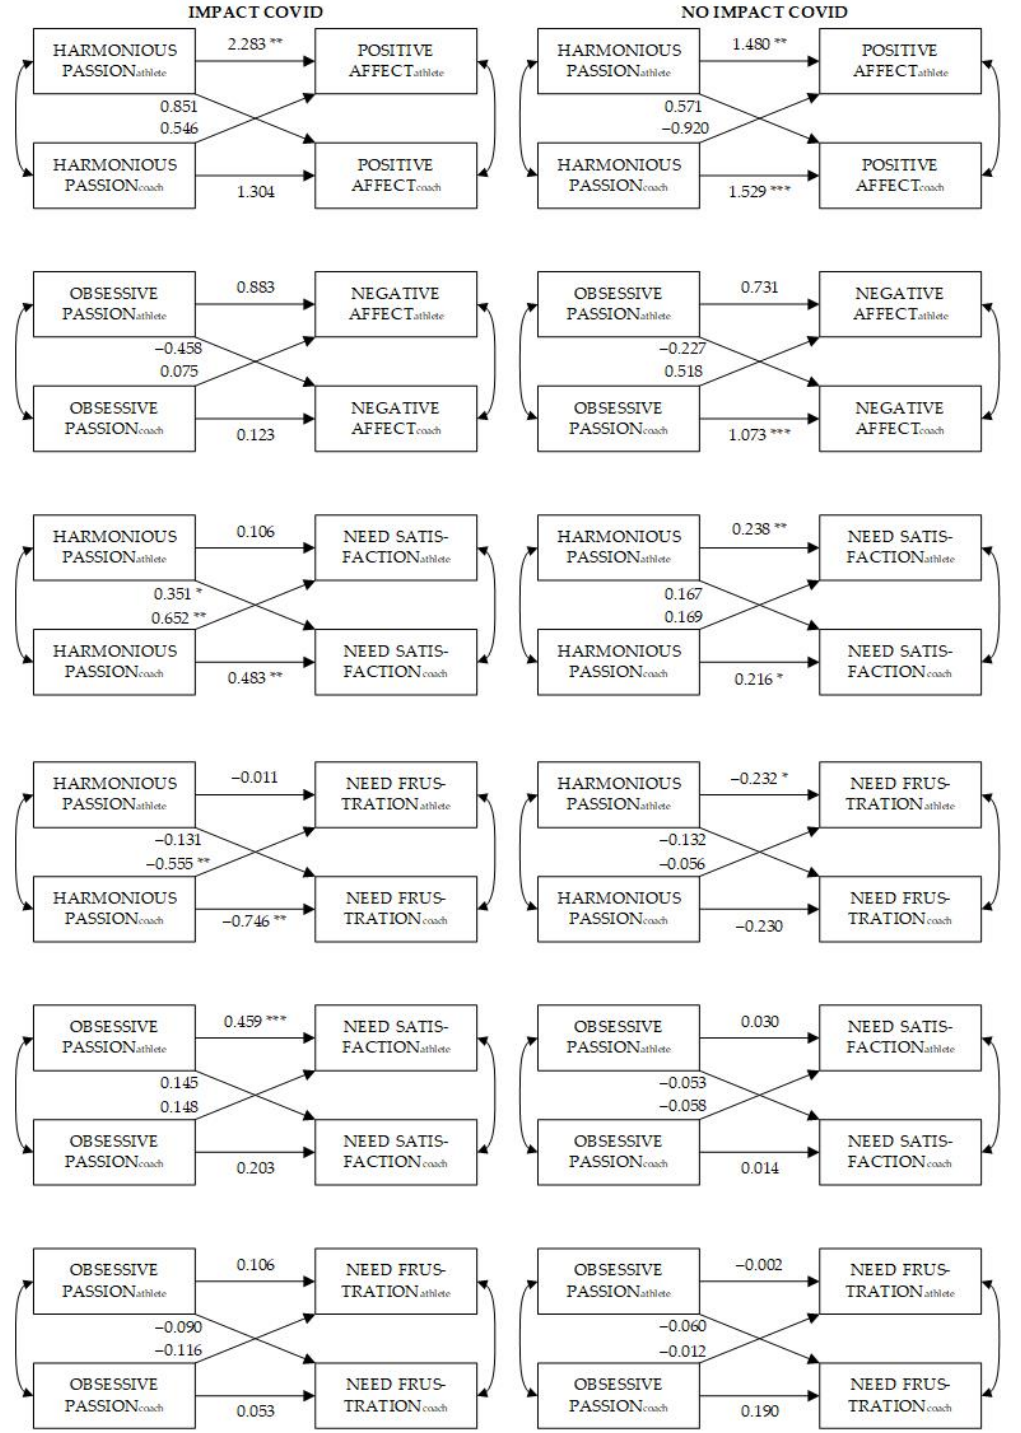
Figure 1. A visual representation of the actor and partner effects of the six moderated Actor–Partner Interdependence models that were fitted. In the left panel, the results of the dyads that were impacted by the pandemic can be found, whereas the results of the not-impacted dyads are displayed in the right panel. *** p < 0.001; ** p < 0.01; * p < 0.05.